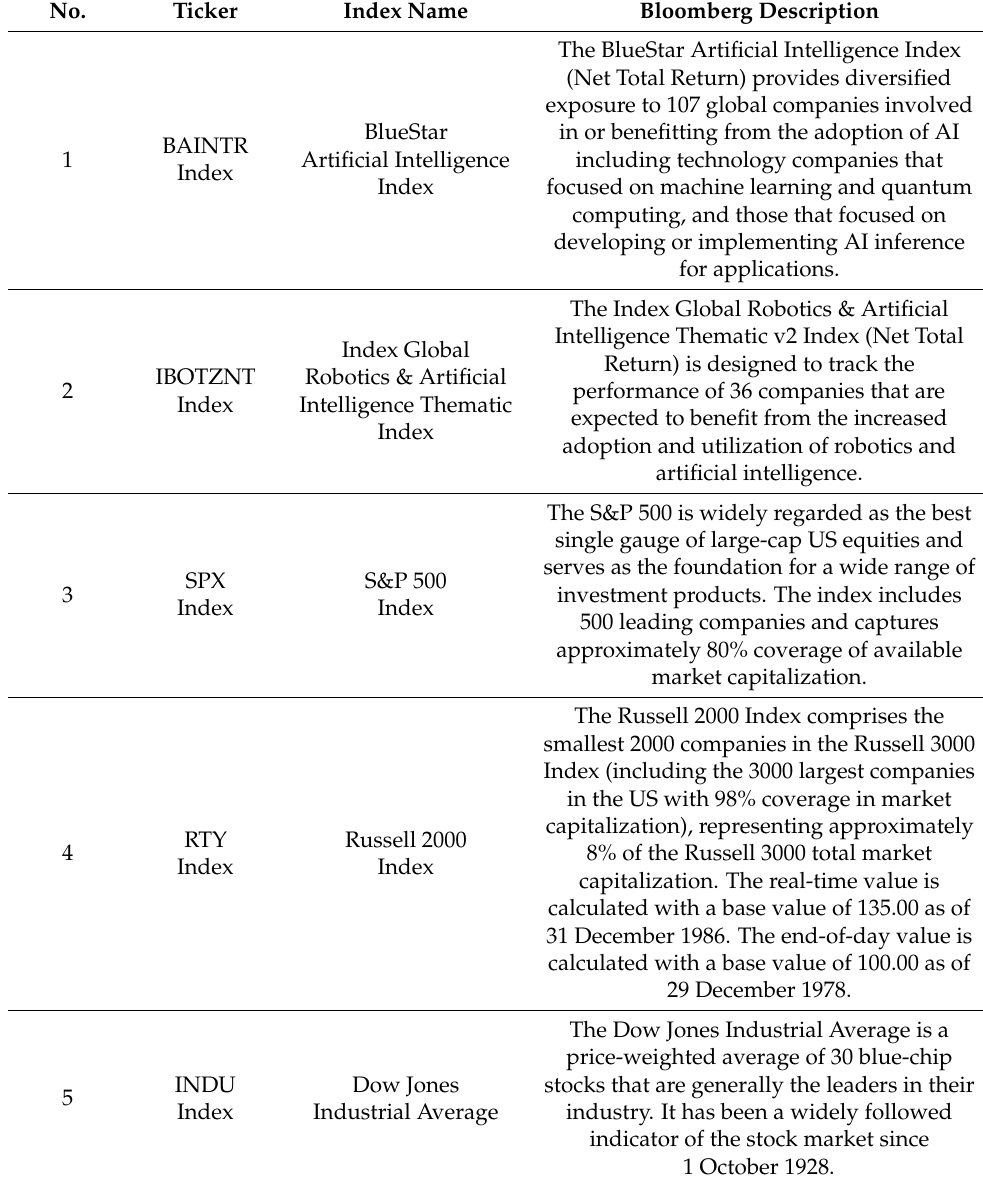
Table 3. Artificial intelligence and conventional market